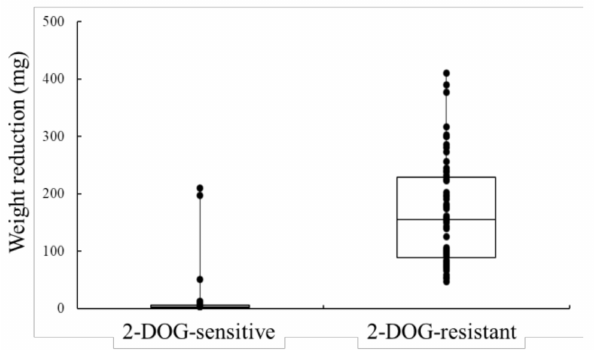
Figure 1. Distribution of the weight reduction (maltose fermentative ability) of 2-deoxyglucose (2-DOG)-sensitive and -resistant haploids isolated from MCD4 as box plots. Vertical axis shows the decrease in weight during incubation for 3 h, as described in the Materials and Methods Section 2. Closed circles indicate weight reduction of each